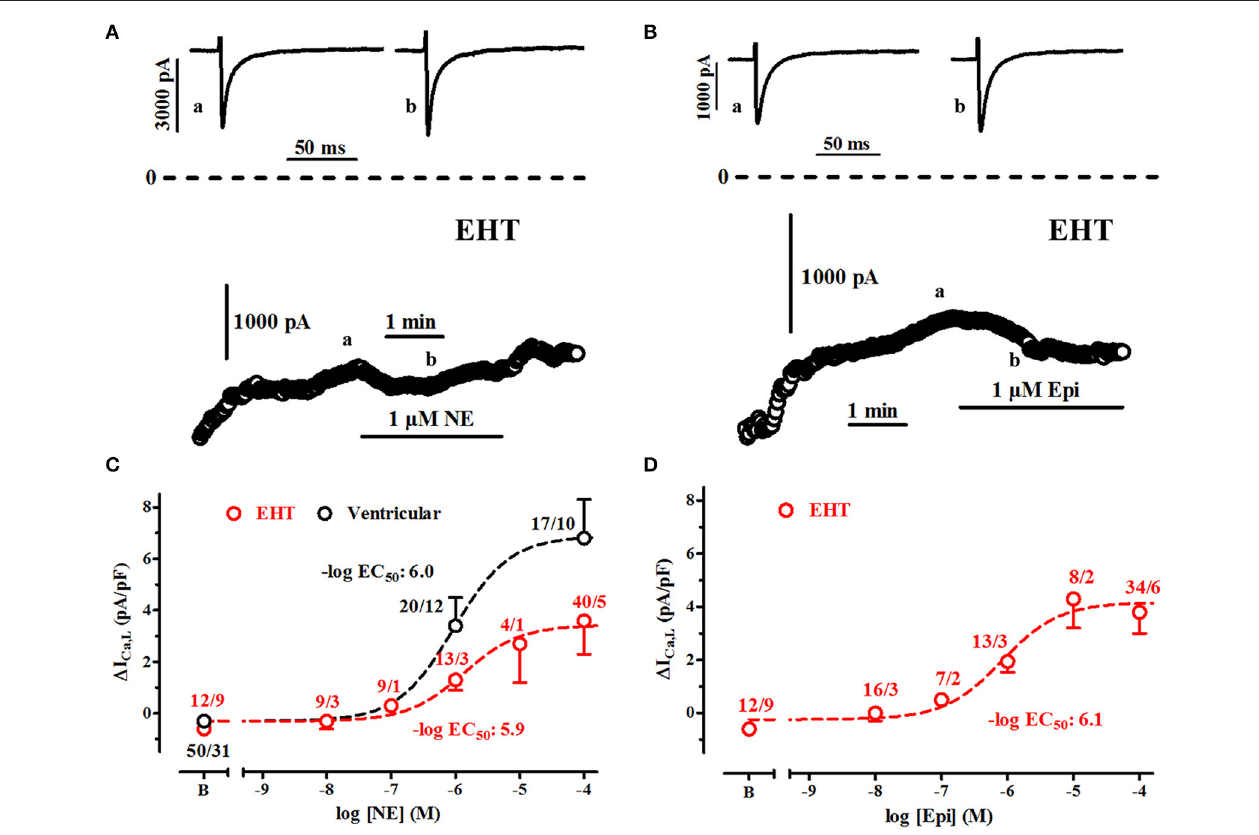
FIGURE 6 | Sensitivity of ICa,L to stimulation of β 1-AR and β 2-AR. (A,B) Time course of ICa in EHT exposed to norepinephrine (NE, 1 µ M) and epinephrine (Epi, 1 µ M). Original tracings taken at time points indicated as a and b. (C,D) Concentration-response curves for the increase of ICa,L upon stimulation of β 1-AR (C) and β 2-AR (D) . Effects are expressed as delta values. Data from ventricular CM are given for comparison in C only. N/N indicates number of cells vs. number of isolation for EHT and number of cells/number patients for ventricular